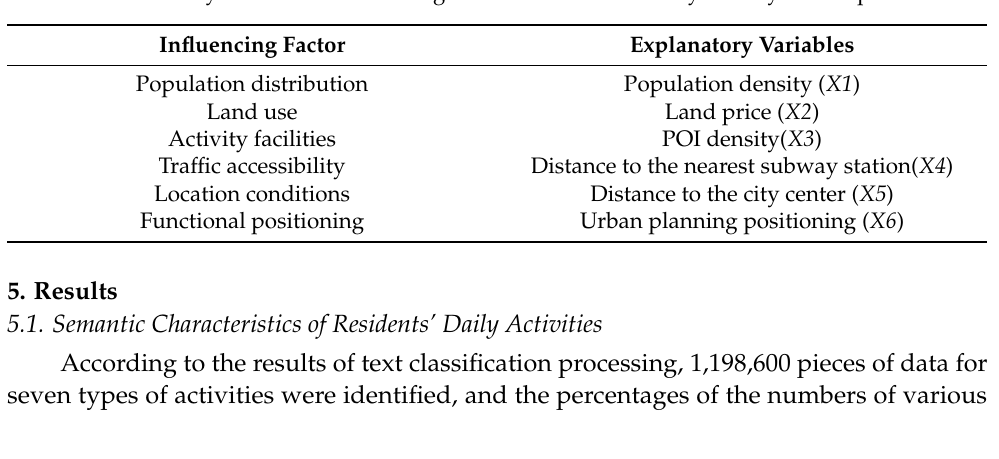
Table 3. The index system of the influencing factors of residents’ daily activity cluster